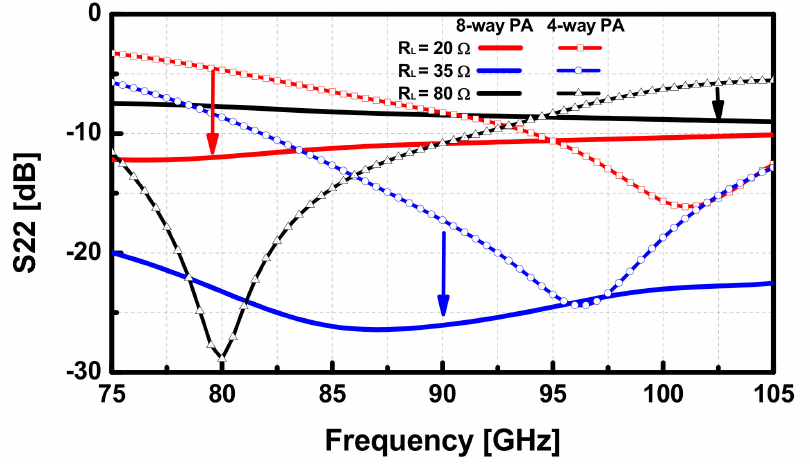
Figure 11. Simulated output return loss (S22) of the 8-way PA and 4-way PA with the load variations.